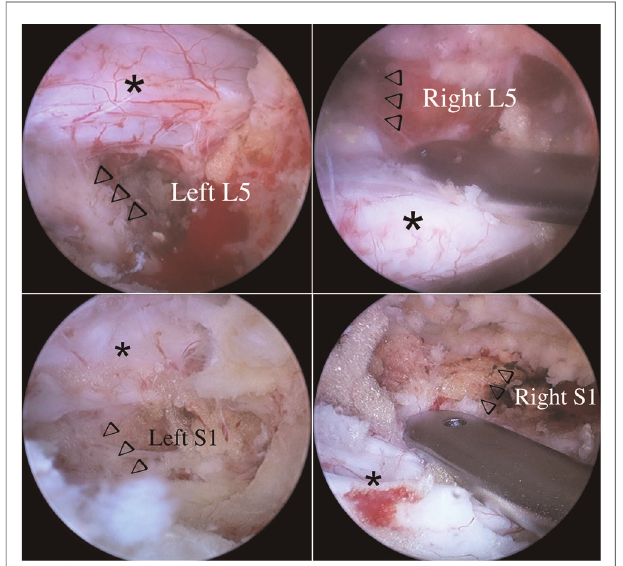
FIGURE 2 | Bilateral L5 and S1 nerve roots and dural sacs after fi rst-stage fi rst stage UBE-ULBD (arrowheads indicate nerve roots, asterisks indicate dural sacs).